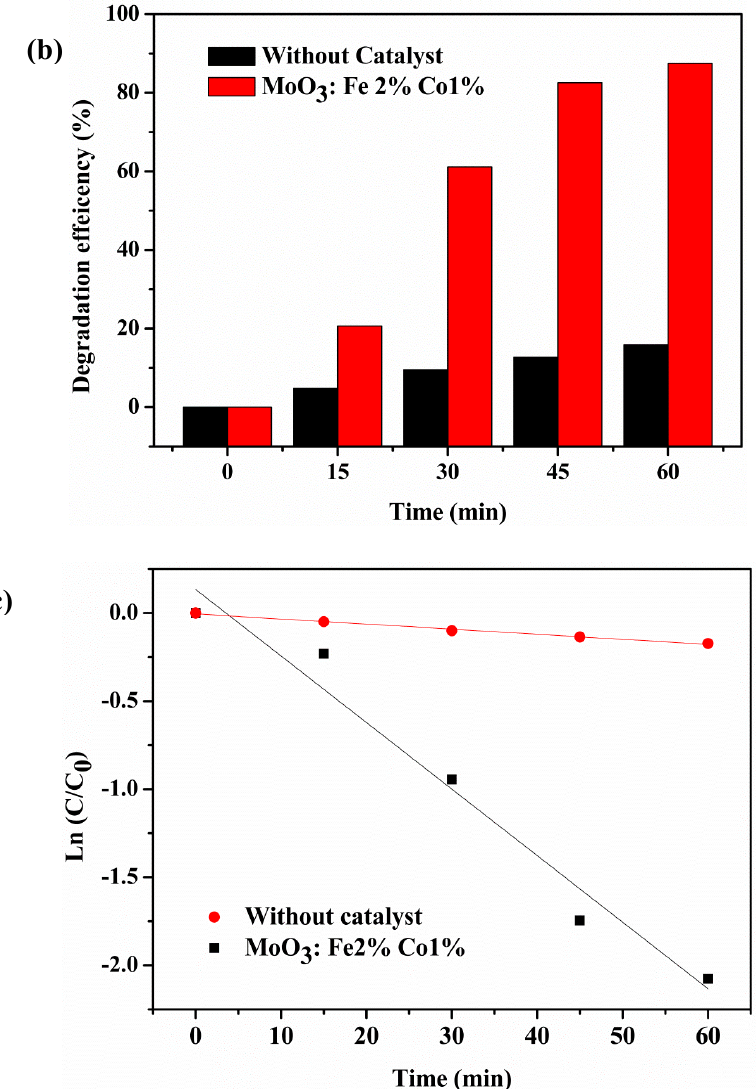
Figure 12. Time-dependent absorption spectra ( a ) of MB dye solution in the presence MoO 3 : Fe 2%-Co 1% ( b ) degradation efficiency and ( c ) degradation kinetics of MB dye.